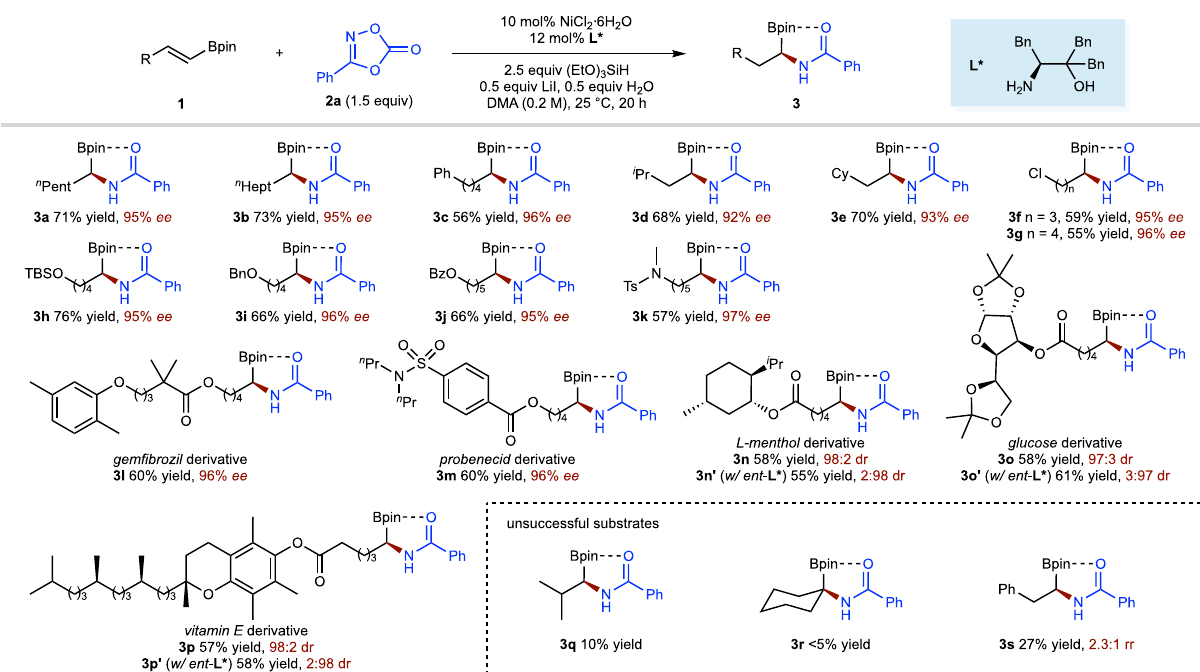
Fig. 3 | Substrate scope of alkenyl boronate coupling partner. Yield under each product refers to the isolated yield of puri fi ed product (0.20mmol scale, average of two runs), enantioselectivities were determined by chiral HPLC analysis. Bpin, pinacol boronic ester; n Hept, n -heptyl.